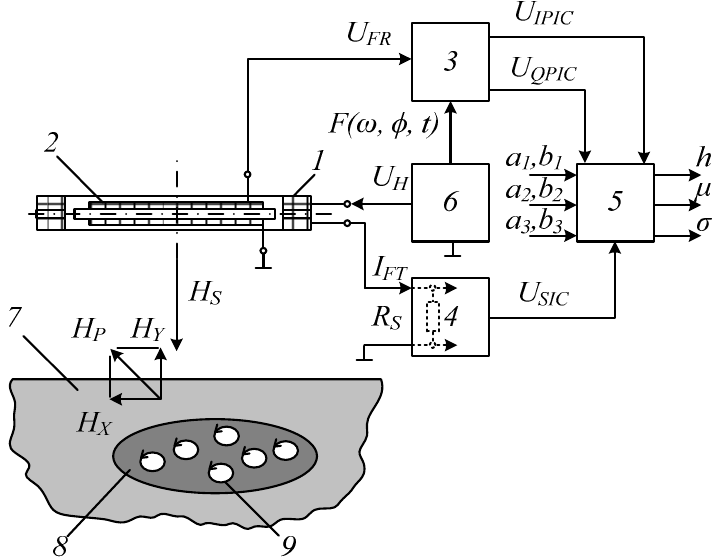
Figure 1. A schematic block diagram of a thermal protection device with the procedure for extracting DC components from alternating phased voltages and currents: 1 is the frame transmitter (FT); 2 is the ferrite receiver (FR); 3 is the registration and in-phase/quadrature conversion of the signal (induction EMF) from the FR, which uses the primary instrumentation channel (PIC); 4 is the registration and conversion of the impedance response of the transmitting FT as induced by the electromagnetic properties of a buried metal object. The secondary instrumentation channel (SIC) is what converts this response into an electrical signal; 5 is the algorithmic processing of the instrumentation data that determines the BO parameters; 6 is the harmonic signal U H generator that excites the primary electromagnetic field; 7 is the containing environment; 8 is a BO; 9 are eddy currents; H P is the magnetic component of the primary electromagnetic field; H S is the polarized magnetic component of the secondary electromagnetic field; H X and H Y are the horizontal and the vertical components of the polarized magnetic component of the secondary electromagnetic field; R S is the measuring shunt; a 1 and b 1 are the PIC static function coefficients for in-phase conversion; a 2 and b 2 are the PIC static function coefficients for quadrature conversion; a 3 and b 3 are the coefficients of the SIC static conversion function; U FR is the data signal (induction EMF) from the FR; U IPIC and U QPIC are the in-phase and the quadrature component of the data signal U FR ; U SIC is the FT data signal; F ( ω ; ϕ ; t ) is the process of synchronizing the PIC conversion procedure to the temporal parameters of the harmonic signal that excites the primary electromagnetic field; σ and µ are the specific electrical conductance and the magnetic permeability of the metal object, respectively; h is the BO location depth.